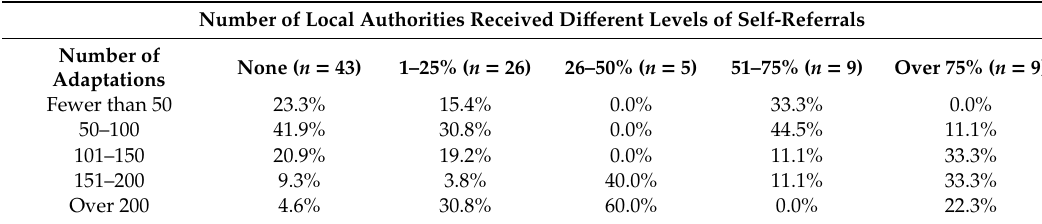
Table 2. Crosstabs between self-referral services and delivery outcomes.